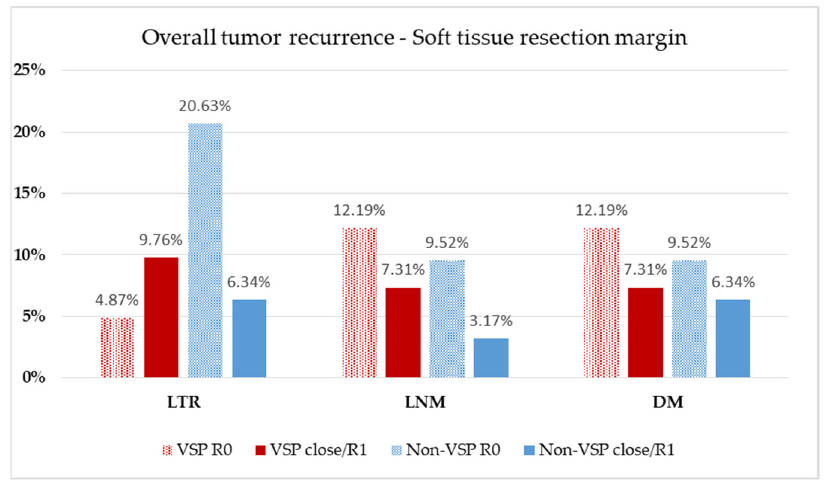
Figure 4. Evaluation of soft tissue resection margin. Relative distribution of local tumor recurrence (LTR), lymph node metastasis (LNM), and distant metastasis (DM) according to the method of reconstruction planning. Patients at risk: VSP group, n = 41 (follow-up, 20.6 ± 16.4 months); non-VSP group: n = 63 (follow-up, 64.9 ± 52.1 months).